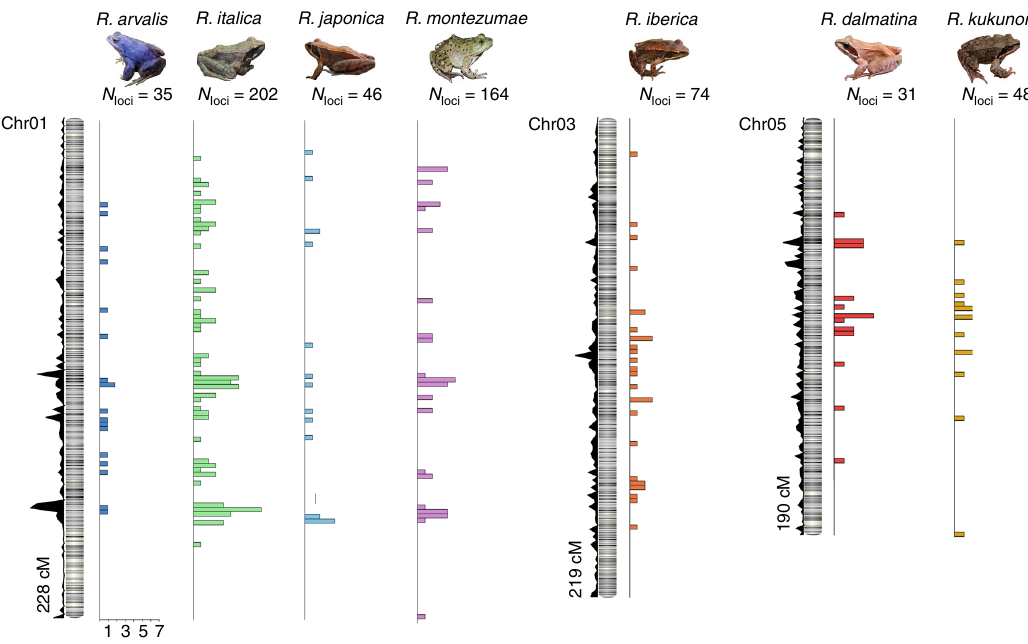
Fig. 3 Chromosome-wide distribution of sex-linked RAD markers in seven true frog species. Density plots to the left of linkage maps show the marker density along the linkage group. Coloured bars are histograms of the number of sex-linked markers along the linkage group, with bins of 2 cM. Picture credits: Jan Jezek ( R. arvalis ), Astolinto ( R. italica ), Yasunori Koide ( R. japonica ), Jim Rorabaugh ( R. montezumae ), DLJ ( R. iberica ), NR ( R. dalmatina ), AB ( R.